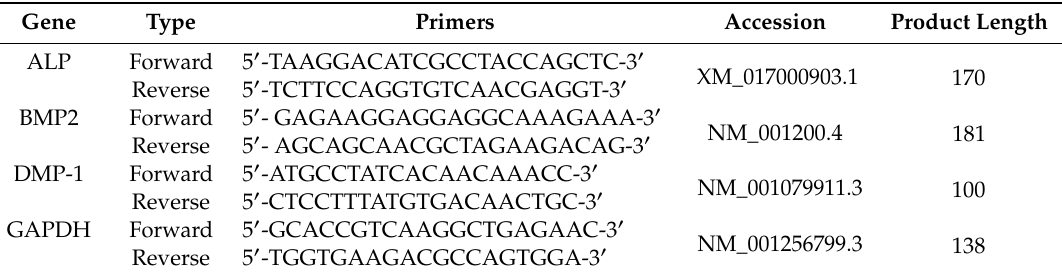
Table 1. Primers used for RT-PCR